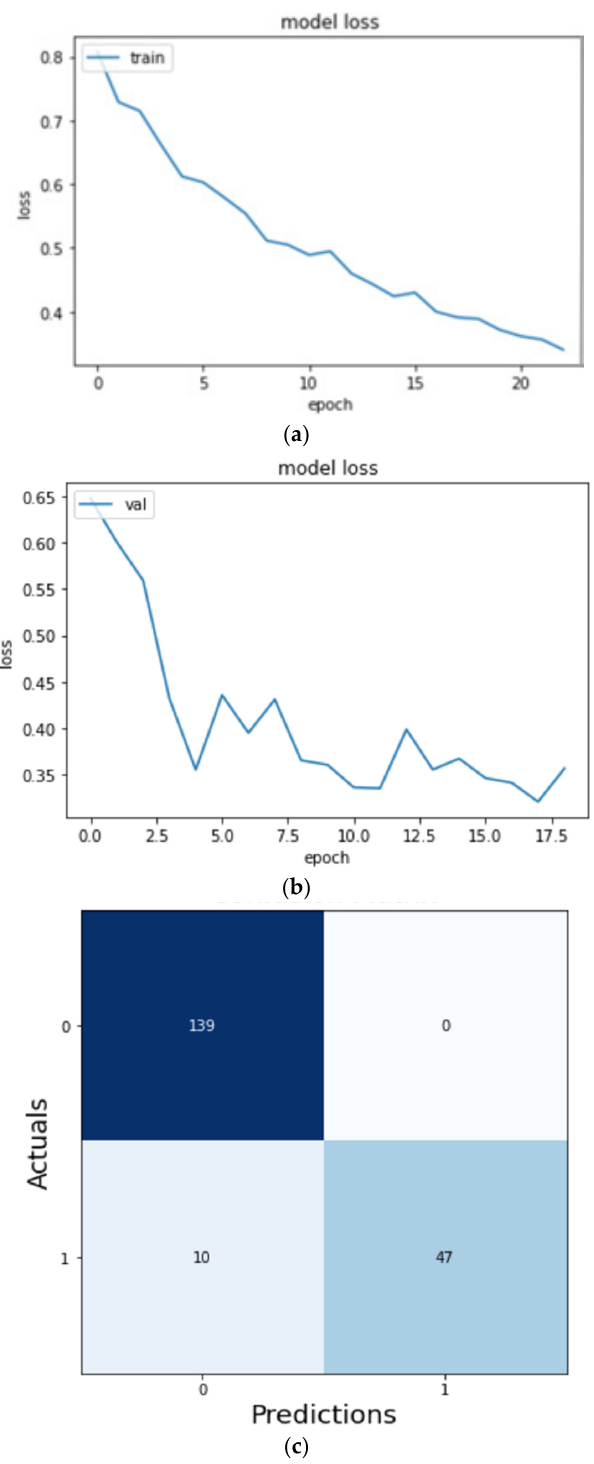
Figure 18. ( a ) Training loss curve, ( b ) validation loss curve, and ( c ) confusion matrix of validation data for ResNet50